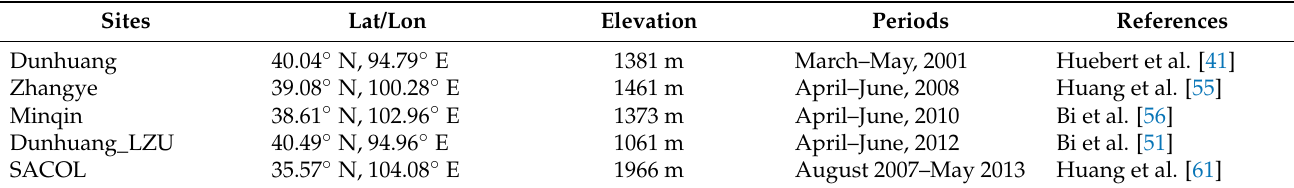
Table 1. The detailed information of the utilized dust field experiments.